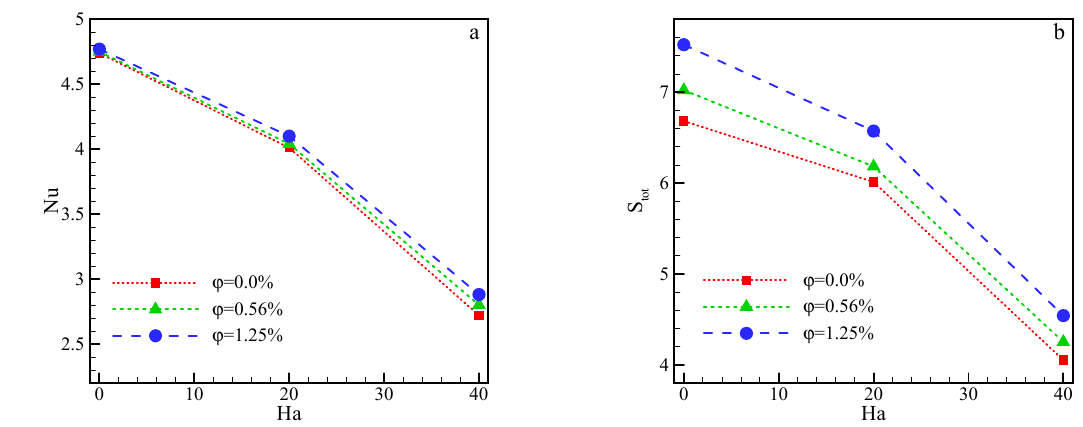
Figure 8. Mid Nu ( a ) and total EGE ( b ) for Ra = 10 5 , Rd = 1, AR = 0.45 − 0.6, γ = 45, ω = 0, and various Ha values and NP solid fractions.